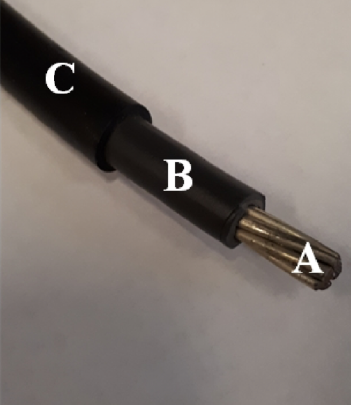
Figure 1. The LV unshielded NPP cable under consideration. A—Tin-coated copper, B—XLPE insulation, C—CSPE jacket.